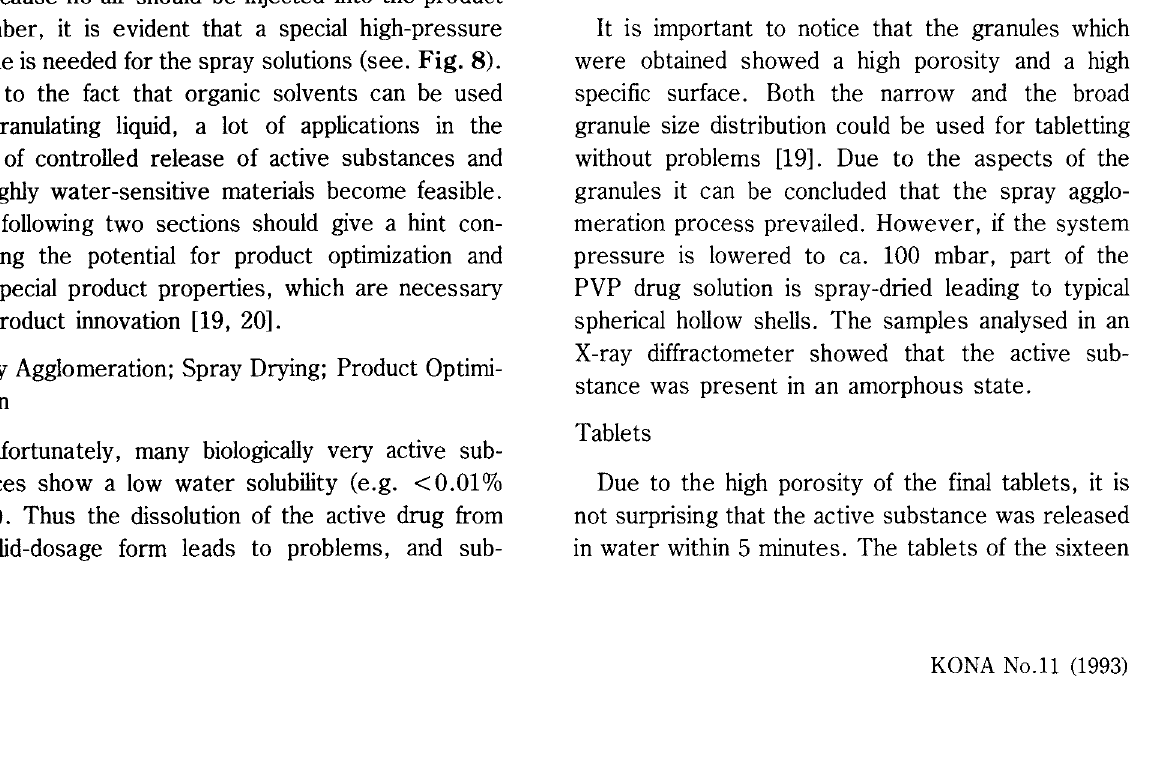
Fig. 10 Drying of a cephalosporin antibiotic-containing water